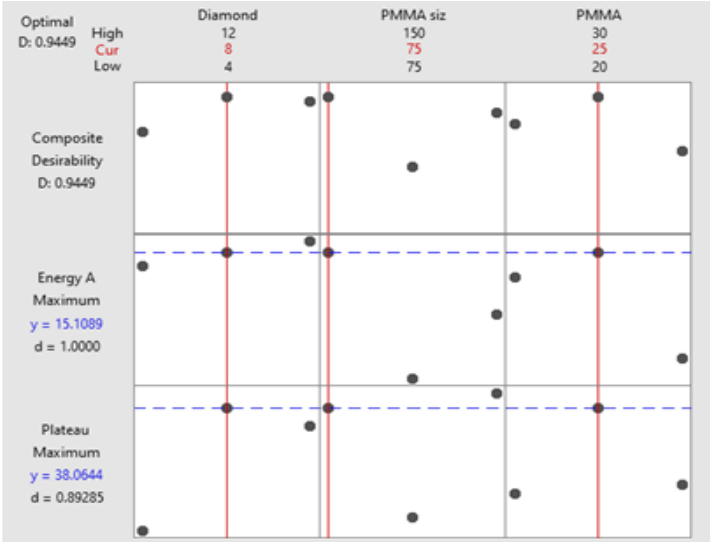
Figure 10. Optimization plot for plateau stress and energy absorption capacities.